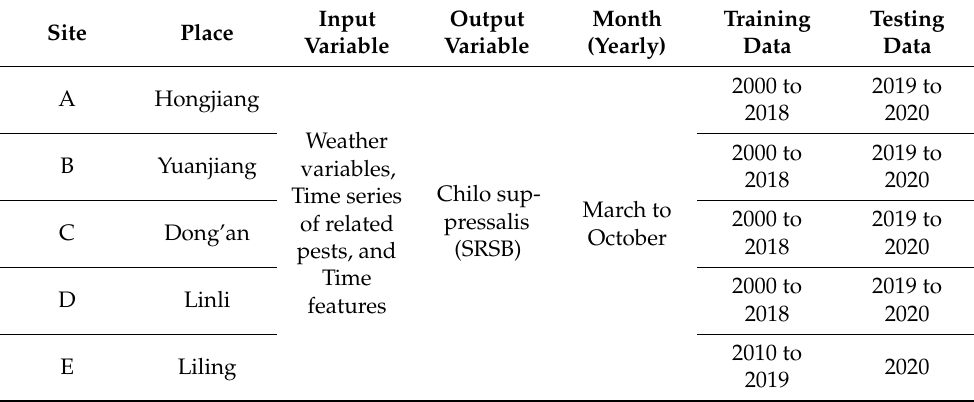
Table 5. Details of the data used in model